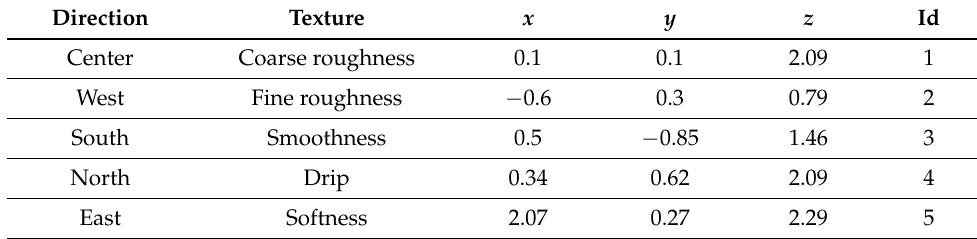
Table 2. Textures’ location and